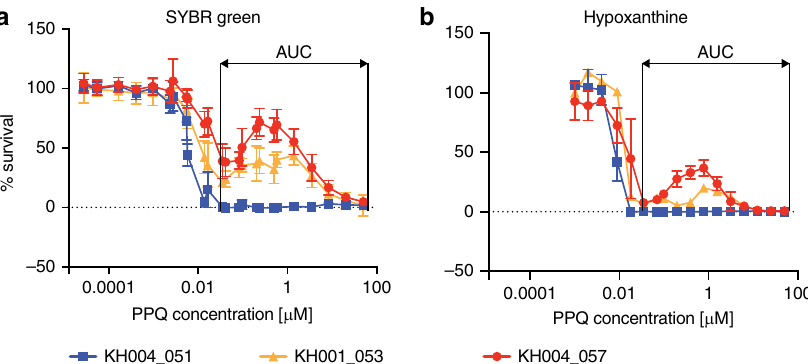
Fig. 1 Bimodal distribution of parasite response to PPQ exposure. The Area Under the Curve (AUC) value was determined using the local minima as boundaries to describe the parasite response to PPQ. Increasing the starting concentration and number of data points for the conventional SYBR Green dose – response curve a provided a better curve representation and brought percent survival to zero at higher concentrations. Bimodal growth was observed with increasing PPQ concentrations for a subset of parasites. Representative PPQ-resistant parasites KH004_057 (red) and KH001_053 (orange) and a PPQ-sensitive parasite KH004_051 (blue) are shown. Similar data for all 37 isolates tested can be found in Supplementary Fig. 1. Hypoxanthine assays b con fi rmed that these dose – response results were derived from viable parasites. All drug assays were done in triplicate and repeated two times, with the mean and s.d. shown for each